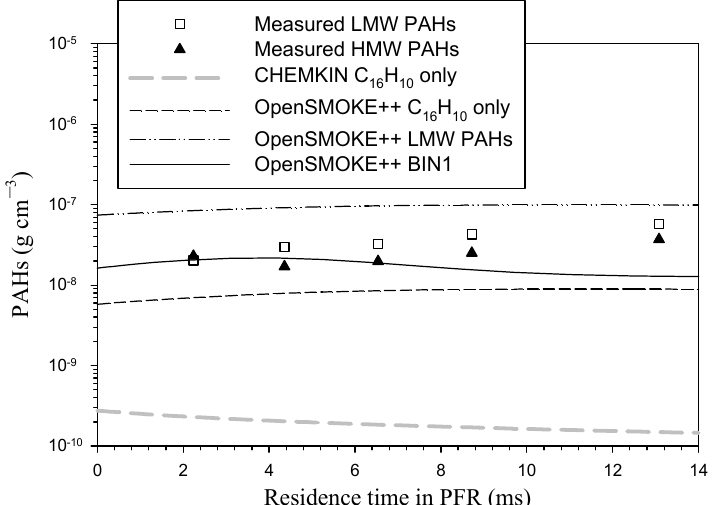
Figure 2. Comparison of C 2 H 2 concentrations predicted by CHEMKIN and OpenSMOKE++ with measured C 2 H 2 concentrations reported by Marr et al. [59].